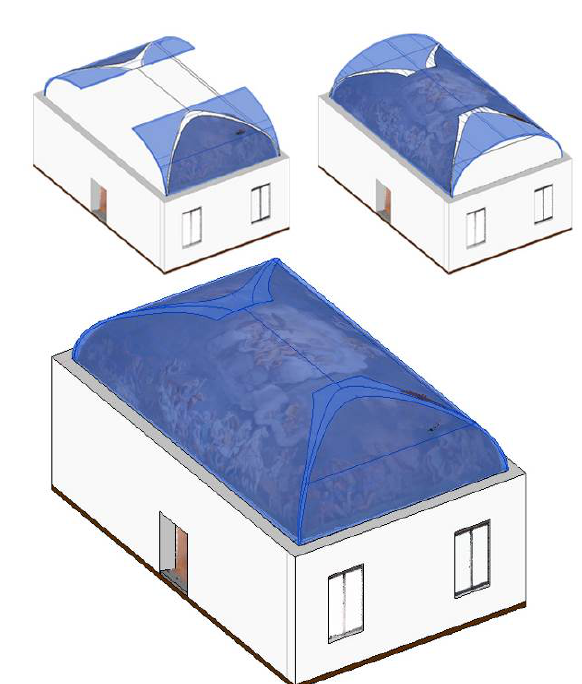
Figure 3: Vault construction by successive subtraction of solids.